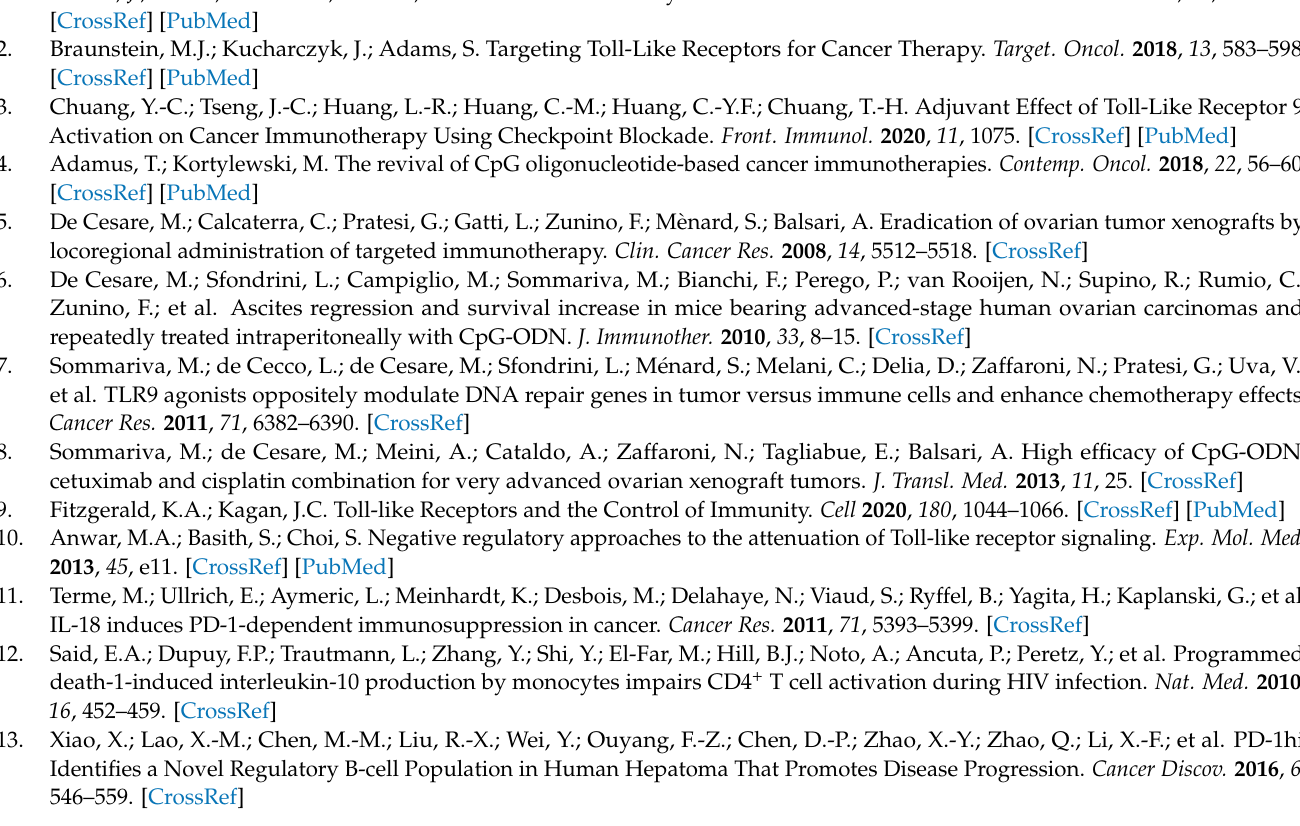
Figure S6: anti-PD-1 antibody F(ab) 2 retains the ability to bind PD-1, Figure S7: modulation of Fc γ R2b and Fc γ R3 expression on RAW264.7 macrophages in vitro by the combination of CpG-ODNs and an anti-mouse PD-1 antibody, Figure S8: evaluation of the ability of in vitro stimulated-BMDMs to modulate NK cell cytotoxic activity, Figure S9: effect of CpG-ODNs in combination with different concentrations of anti-mouse PD-1 antibody on RAW264.7 macrophages in vitro. Table S1: List of TaqMan ® gene expression assays utilized for Real Time PCR analysis, Table S2: effect of CpG- ODN and anti-PD-1 antibody combination on ascites appearance in IGROV-1 tumor-bearing mice, Supplementary Figure